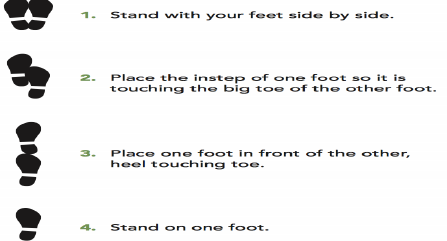
Figure 2: The 4-stage balance